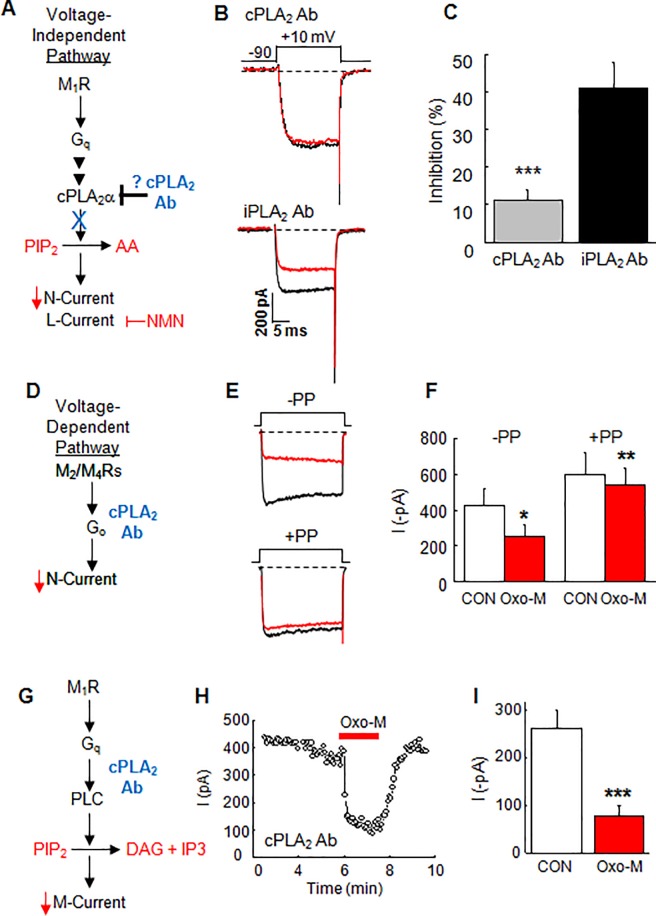
cPLA2α is required for inhibition of whole-cell N-current by Oxo-M in SCG neurons.(A) Schematic of experimental conditions. (B) Individual traces illustrating that dialyzing SCG neurons with cPLA2α Abs (Abs, 1:500) minimizes N-current inhibition (n = 8) compared to robust current inhibition (41.2 ± 7.02%) of neurons dialyzed with iPLA2 Abs (1:200; n = 4). (C) Summary bar graph illustrating the significant difference (***p ≤ 0.001) between the average current inhibition with cPLA2α versus iPLA2 Abs (n = 4-8/group). (D) Schematic of membrane-delimited pathway. (E) Individual traces showing N-current inhibition by Oxo-M (red traces) in cells dialyzed with Ab in the absence (-PP) or following (+PP) a prepulse. (F) Summary bar graph of control (open bars) and Ox-M inhibited (red bars) N-current amplitude with -PP or +PP protocols. Following Oxo-M, significant inhibition (*p ≤ 0.05; n = 5) occurred in the absence of a prepulse (-PP), which was completely relieved (**p ≤ 0.005; n = 5/group) with a prepulse (+PP). (G) Schematic showing the cPLA2α Ab should not affect M-current inhibition by Oxo-M. (H) Example time course showing rapid, reversible M-current inhibition in SCG neurons dialyzed with Ab. (I) Summary bar graph showing significant (***p ≤ 0.0005; n = 8) M-current inhibition by Oxo-M.